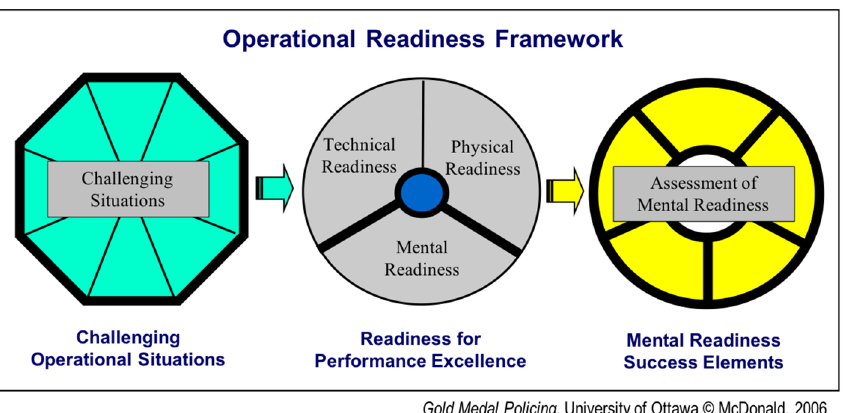
Figure 1. Three stages of the Operational Readiness Framework [21] (p. 2).